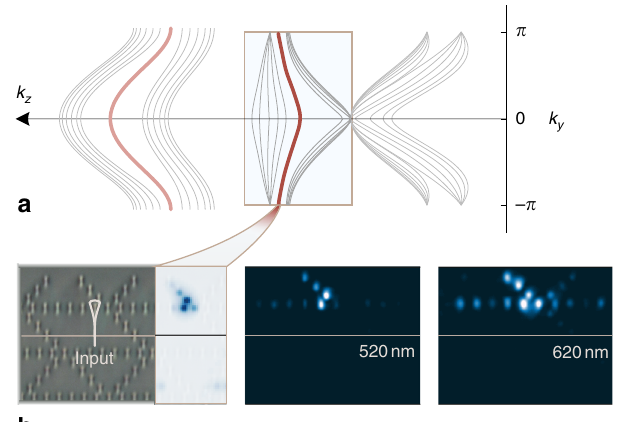
Fig. 4 Secondary modes. a Ribbon band diagram of the type-II lattice. The fi rst modal group is associated with the main results of Figs. 2 and 3. Lower energy bands exhibit additional pairs of edge states. b By probing a different site, we excite the secondary edge eigenstate shown as overlay on the micrograph panel. The experimental results are captured for two different wavelengths of the laser